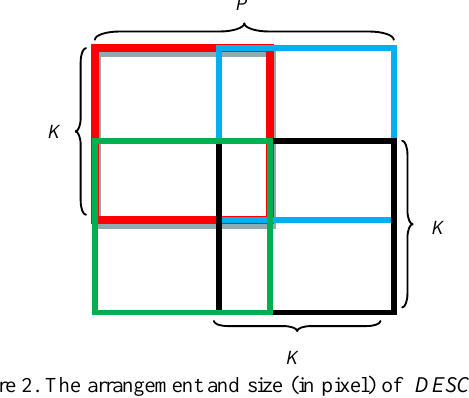
Figure 2. The arrangement and size (in pixel) of DESC-1. The learned autoencoder is applied to each of the 4 coloured regions, and the resulting feature vectors are concatenated to form the final key point descriptor.